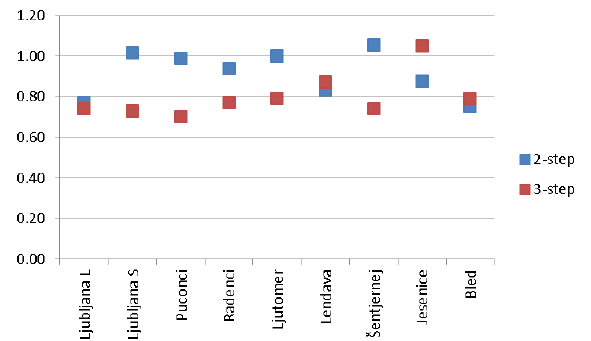
Figure 7. Average RMSE in pixels at 80% best extracted GCPs per image, for nine WorldView-2 images of levels 1B and 2A. Blue dots: original 2-step algorithm consisting of robust and fine matching. Red dots: improved 3-step algorithm with the added super-fine matching step.